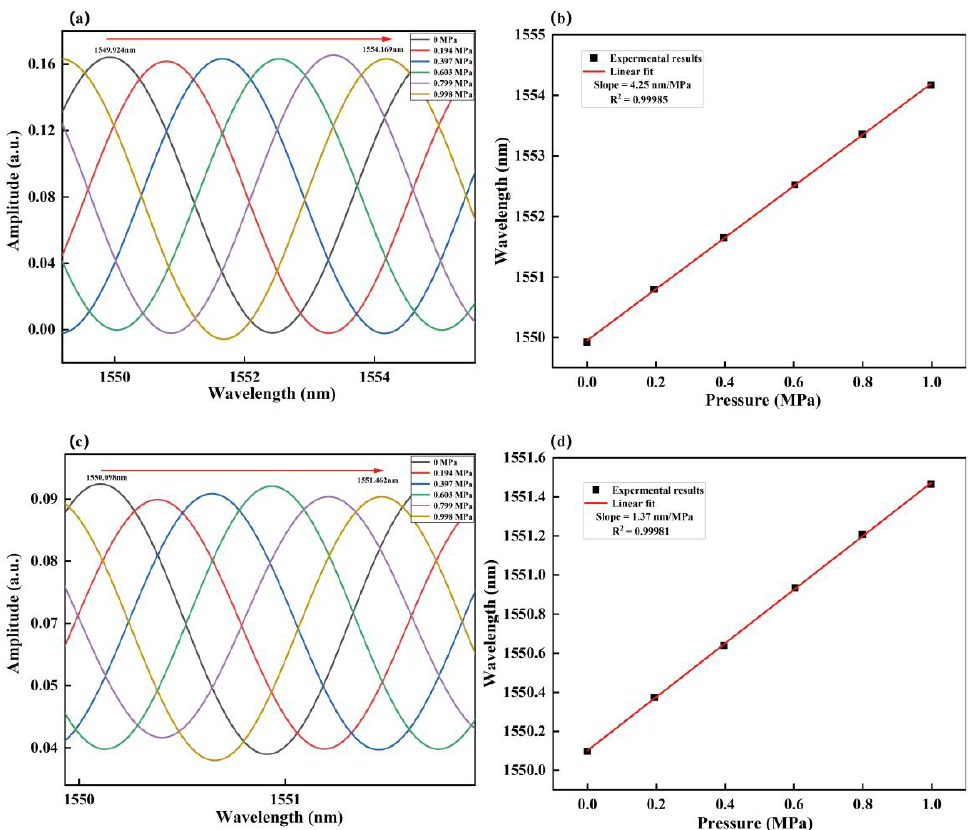
Figure 6. The extracted interference spectra of ( a ) Cavity–1 and ( c ) Cavity–3 at different gas pressures; The pressure responses of ( b ) Cavity–1 and ( d ) Cavity–3 at room temperature.